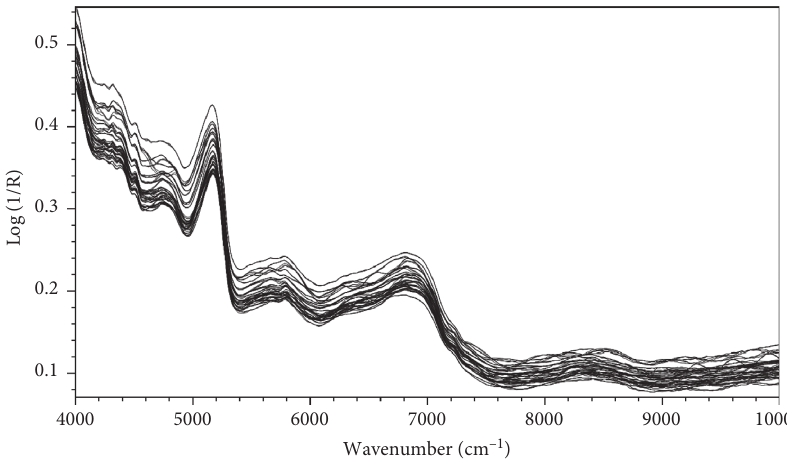
Figure 1: NIR absorbance spectra of the grinded A. millefolium plants. Table 2: Comparison of the optimized parameters for developing the NIR single-compound regression models (SCM) and the multiple compound regression model